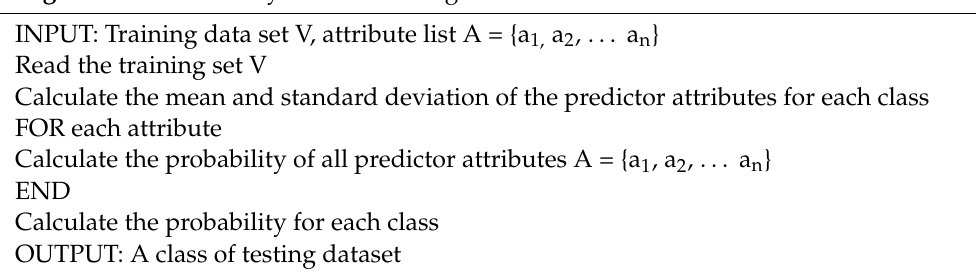
Algorithm 3: Naïve Bayes Classifier